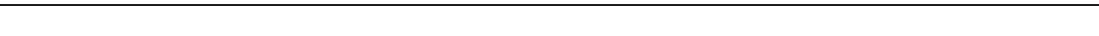
Fig. 5 Deacetylation of K126 on GKRP by Sirt2 facilitates GK − GKRP dissociation and hepatocyte glucose uptake. a , b Comparison of the acetylation levels of wild-type (WT) GKRP, eight GKRP Lys-to-Arg mutants ( a ), and eight GKRP Lys-to-Gln mutants ( b ) in HEK293 cells expressing Flag-tagged Sirt2 or not. c The acetylation levels of GKRP in primary hepatocytes derived from db/db mice transfected with adenovirus encoding Flag-tagged GKRP-wild-type (Flag- GKRP-WT) or Flag-tagged GKRP-K126R (Flag-GKRP-K126R). Endo. endogenous GKRP, Exo. exogenous GKRP. d Effect of Sirt2 knockdown on glucokinase (GK) − GKRP binding in primary hepatocytes transfected with adenovirus encoding HA-tagged GK (HA-GK) and Flag-GKRP-WT or Flag-GKRP-K126R in low- and high-glucose medium. e Effect of nicotinamide (NAM) on GK − GKRP binding in mouse primary hepatocytes transfected with adenovirus encoding GK and Flag-GKRP-WT or Flag-GKRP-K126R in high-glucose medium. f , g Effect of Sirt2 knockdown ( f ) or NAM ( g ) on 2-deoxyglucose (2-DG) uptake in mouse primary hepatocytes transfected with adenovirus vector encoding Flag-GKRP-WT or Flag-GKRP-K126R ( n = 4). h Immunoprecipitation and immunoblot analysis of GK − GKRP binding in db/db mouse primary hepatocytes transfected with adenovirus encoding HA-GK and Flag-GKRP-WT or Flag- GKRP-K126R in low- and high-glucose medium. i , j NAD+ ( i ) and 2-DG uptake ( j ) levels in db/db mouse primary hepatocytes transfected with adenovirus vector encoding Flag-GKRP-WT and Flag-GKRP-K126R ( n = 5). k , l Effect of Sirt2 knockdown ( k ) and NAM ( l ) on GK − GKRP binding in primary hepatocytes transfected with adenovirus vectors encoding HA-GK or GK and Flag-GKRP-WT or Flag-tagged GKRP-K126Q (Flag-GKRP-K126Q) in high-glucose medium. m , n Effect of Sirt2 knockdown ( m ) or NAM ( n ) on 2-DG uptake in primary hepatocytes transfected with adenovirus vectors encoding Flag-GKRP-WT or Flag-GKRP-K126Q ( n = 4). * P < 0.05; one-way ANOVA with the Fisher ’ s PLSD post-hoc test ( f , g , m , n ) and Student ’ s t -test ( i , j ). Data in a – e , h , k , l are representative of at least three independent experiments. Error bars show